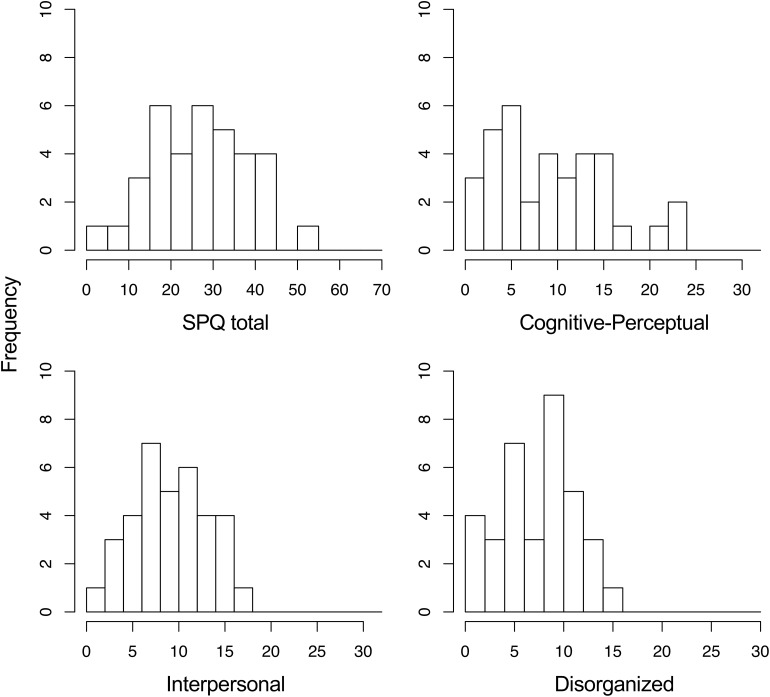
Distributions of the Schizotypal Personality Questionnaire (SPQ) scores (possible score ranges: total, 0–74; Cognitive-Perceptual, 0–33; Interpersonal, 0–25; Disorganized, 0–16).